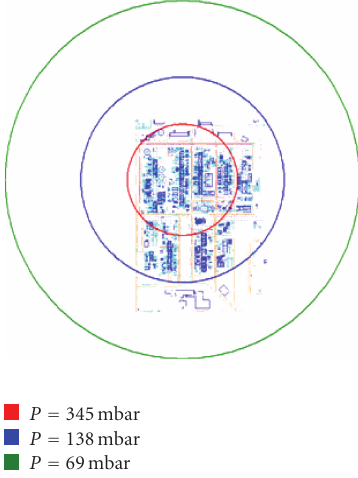
Figure 12: Cloud shape T2302. The cloud stretches over two separate process areas.